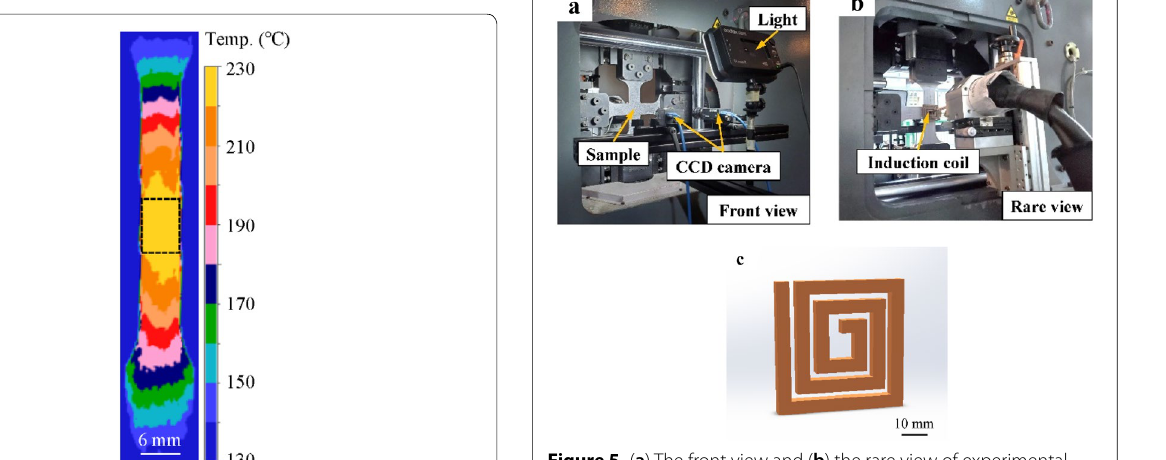
Figure 5 ( a ) The front view and ( b ) the rare view of experimental set-up for biaxial tensile tests with the aids of induction heating